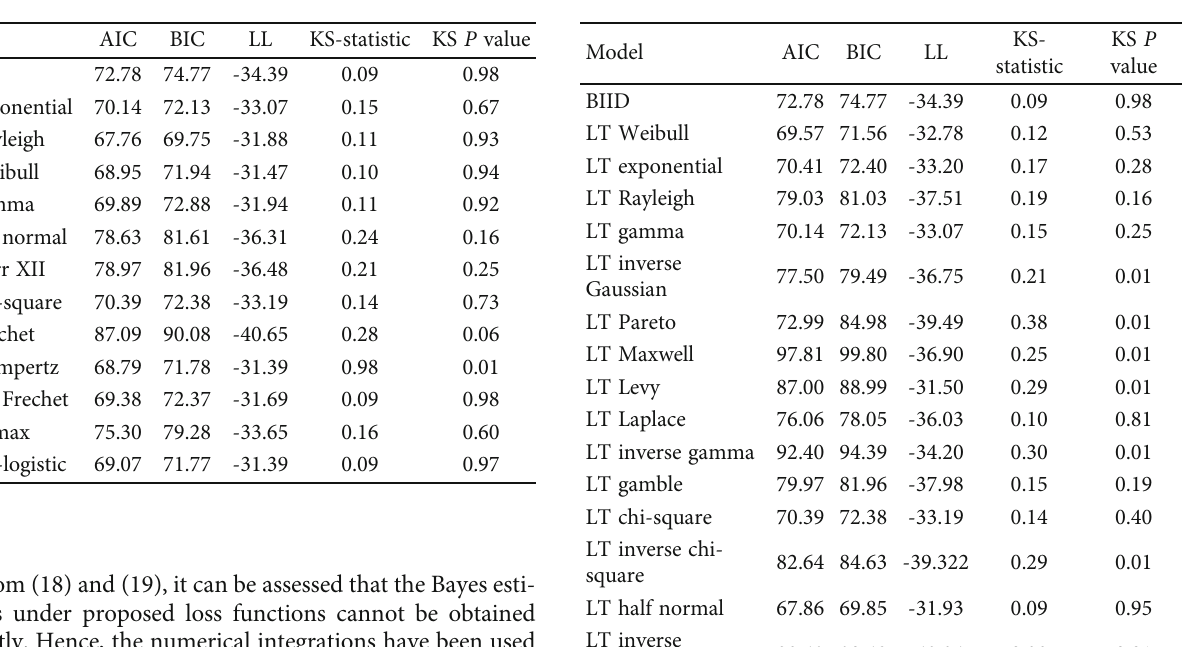
Table 18: Comparison of BIID with class of LTDs using real